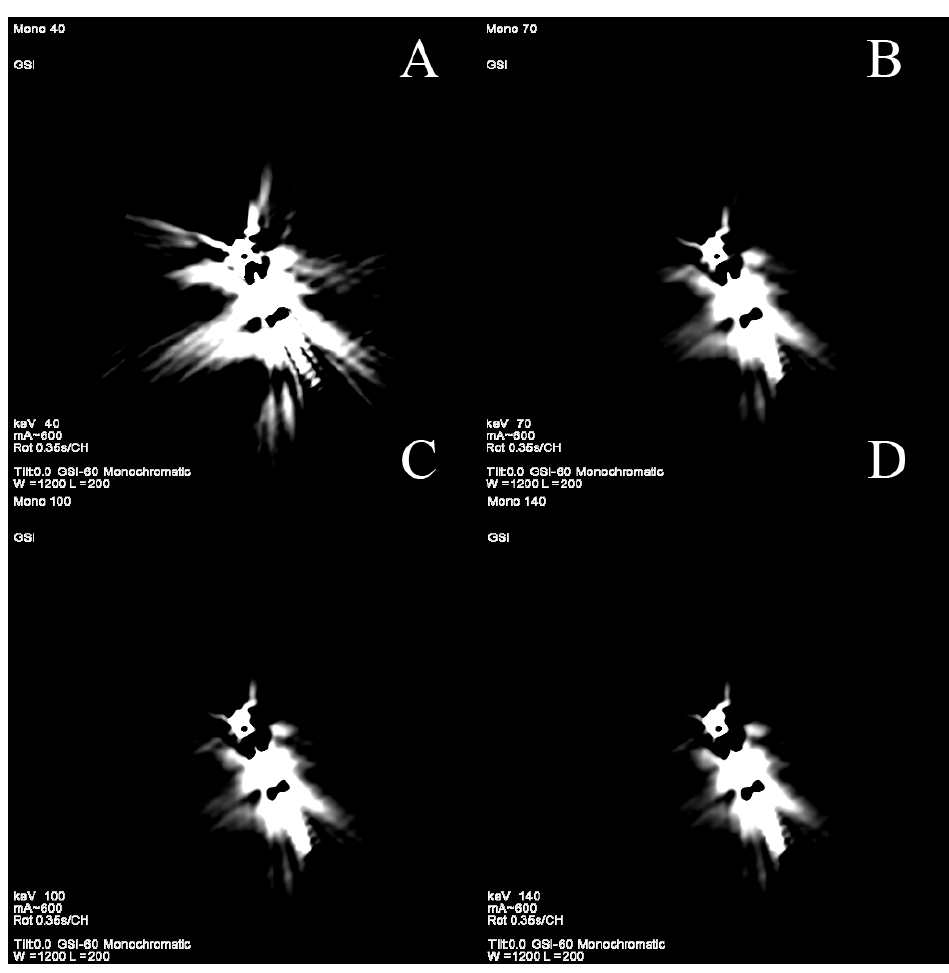
Figure 8. ( A – D ). Reduction in artifacts originating from pacemaker electrode using high-energy VMI ( C , D ). Phantom study. GSI, gemstone spectral imaging.